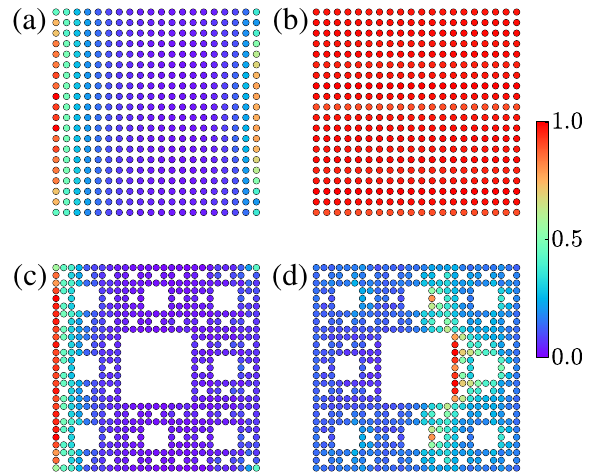
Fig. 1 First-order non-Hermitian (NH) skin effect on a square lattice and Sierpinski carpet (SC) fractal. a Total weight of all the left eigenvectors (normalized by its maximum value) of H FO [Eq. (1)] on a square lattice with open boundary condition (OBC), displaying NH skin effect at outer left edge. b Same as a but with periodic boundary condition (PBC) in the x direction, showing no skin effect. c Same as a , but on a SC fractal of third generation (containing 512 sites) with OBC, showing NH skin effect at its outer left edge. d Same as c , but with PBC only in the x direction, con fi rming the proposed NH inner skin effect at its inner left edges. The outcomes in b and d remain qualitatively unchanged with additional PBC in the y direction. Here we set m 0 = 0, h = (0.4, 0, 0), t = t 0 = 1, r 0 = a , and R = 2 a , where a is the distance between the nearest-neighbor sites [Eq. (2)]. For right eigenvectors the skin effect appears on the right edges. See Supplementary Fig. 1.